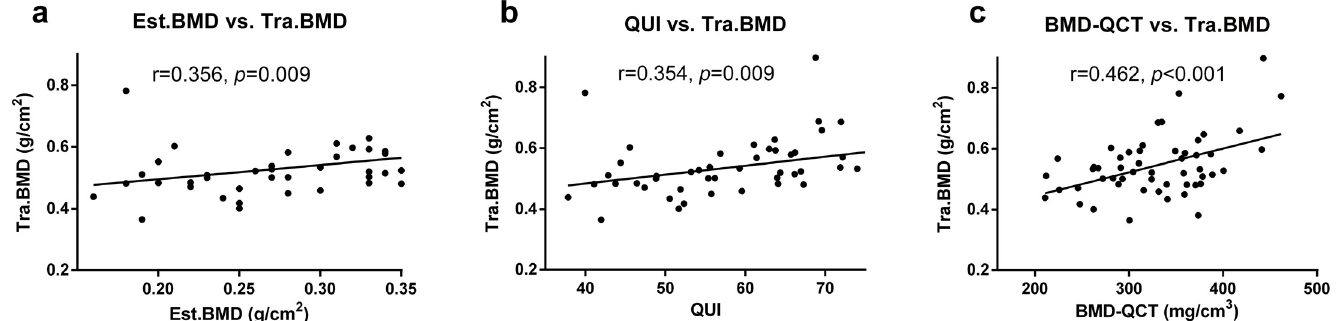
Fig 2. Pearson ’ s correlations between BMD values from the QUS, QCT, and DXA studies. The Est.BMD significantly correlated with the Tra.BMD (Fig 2a). The QUI significantly correlated with the Tra.BMD (Fig 2b). The BMD-QCT significantly correlated with the Tra.BMD (Fig 2c). The Tra.BMD indicates the BMD of the trochanteric area.